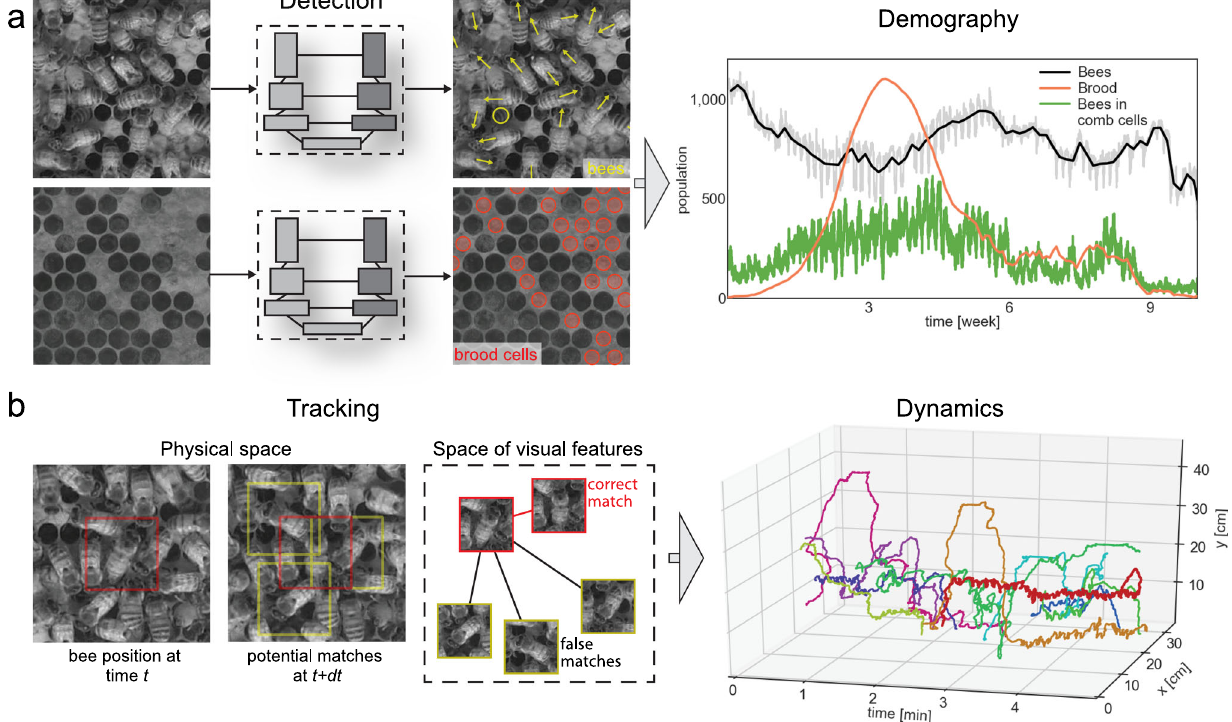
Fig. 1 Schematic of the detection and tracking methods. a A segmentation architecture was used and adapted independently for two tasks: the detection of bees and of brood cells in the dense environment of a bee colony. We use this architecture to infer bee and brood positions (yellow and red marks, respectively), bee posture type — bee inside of a comb cell (yellow round symbols, denoted later as cell-bees) and fully visible bee (yellow arrows, denoted later as full-bees) — and the orientation angle of the fully visible bees (angle of the yellow arrows). Bee and brood locations, as well as within-cell state, allow for detailed sociometric analyses over long timespans and across multiple colonies (right). b CNN-derived embeddings of bee images are used to link detections across video frames into trajectories. The network is trained to maximize the Euclidean distance between detections belonging to different trajectories and minimize this distance between detections of the same bee within one trajectory, which is symbolically illustrated in the middle panel. This visual similarity metric allows for accurate construction of trajectories of unmarked bees and analysis of dynamic aspects of bee colonies. (right) For illustration we show ten tracked trajectories, likely corresponding to forager bees. The red trajectory belongs to a bee that entered the hive around minute 2 of the recording and performed rapid back-and-forth dancing motion for the next 2